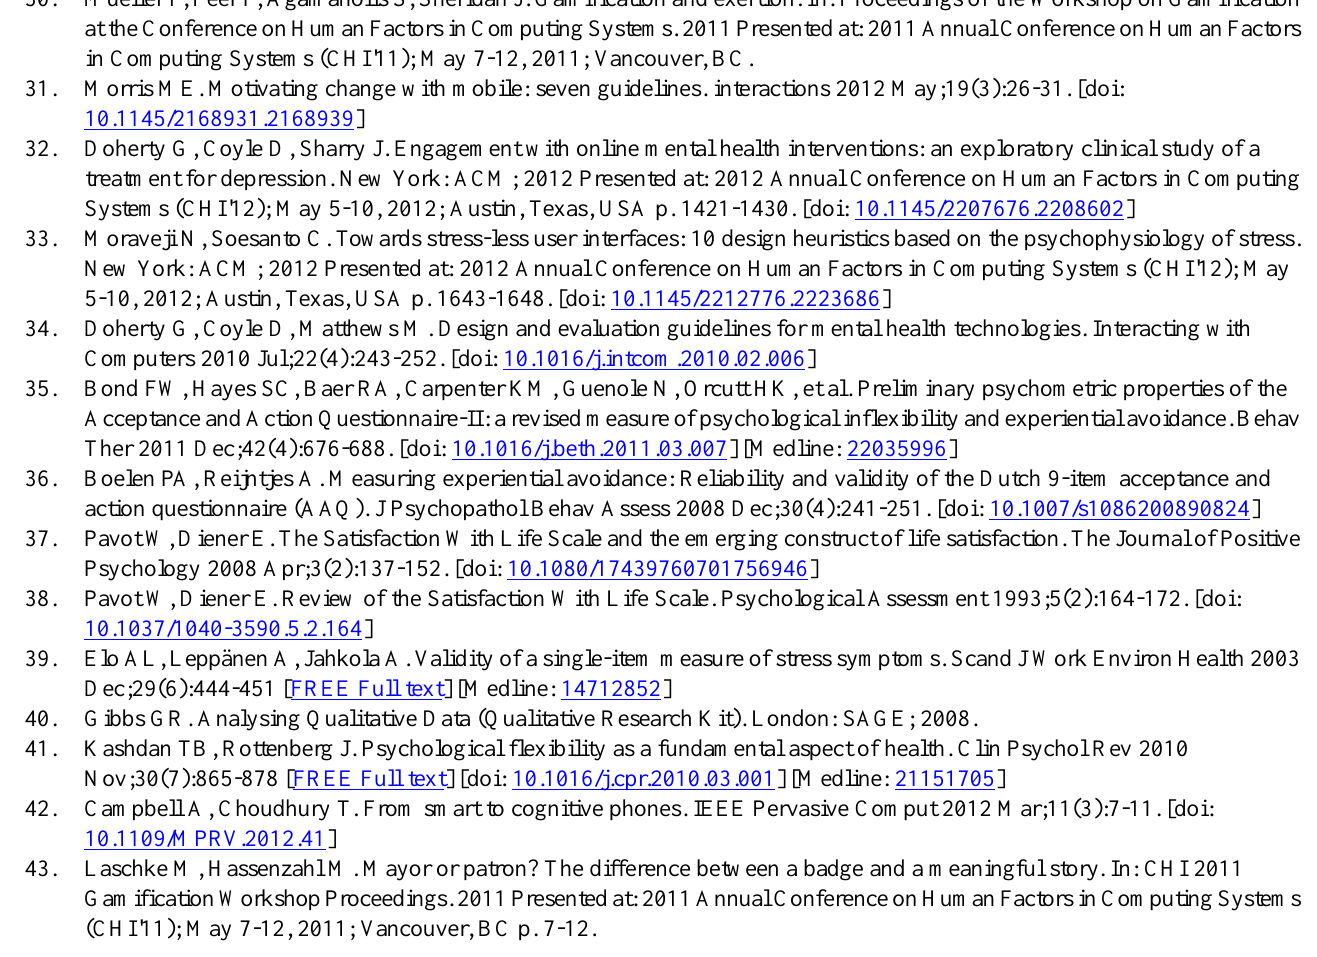
CBT: cognitive behavioral therapy SEM: standard error of